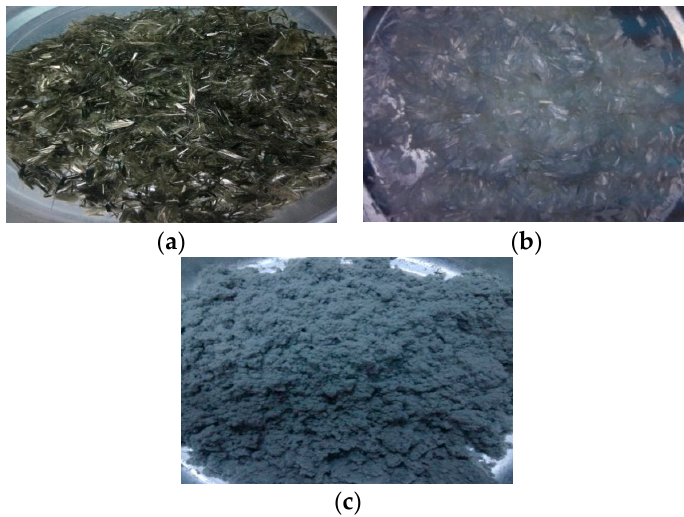
Figure 1. Basic appearance of three kinds of fibers: ( a ) Basalt fiber; ( b ) Polyester fiber; ( c ) Lignin fiber.